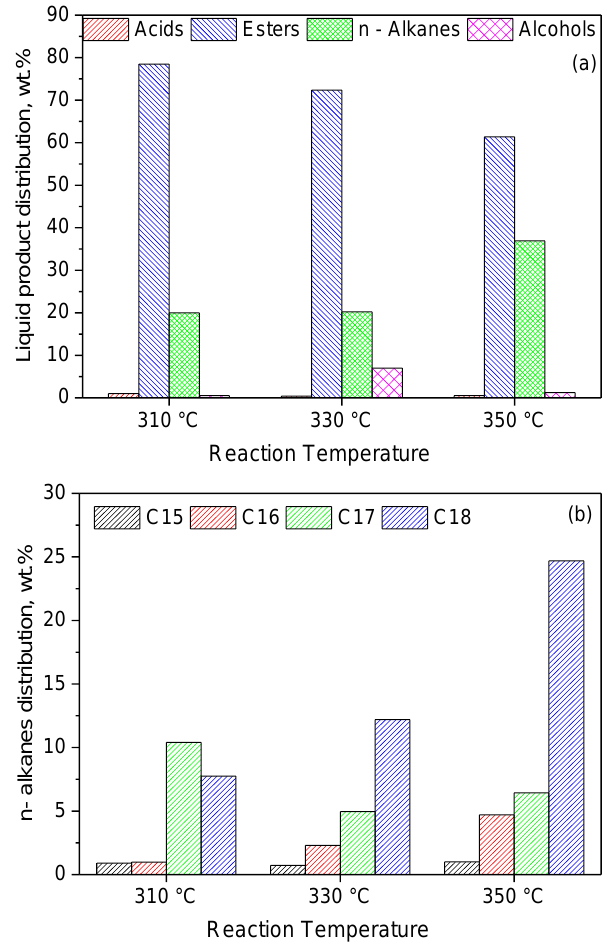
Figure 14. Composition of the liquid phase in n-alkanes, acids, alcohols and esters ( a ) and n – alkanes distribution ( b ), obtained for various reaction temperatures over 1 g of the 20Ni2Mo/MM(H) catalyst, after 9 h of reaction (reaction conditions: 100 mL of WCO, 𝑃 𝐻